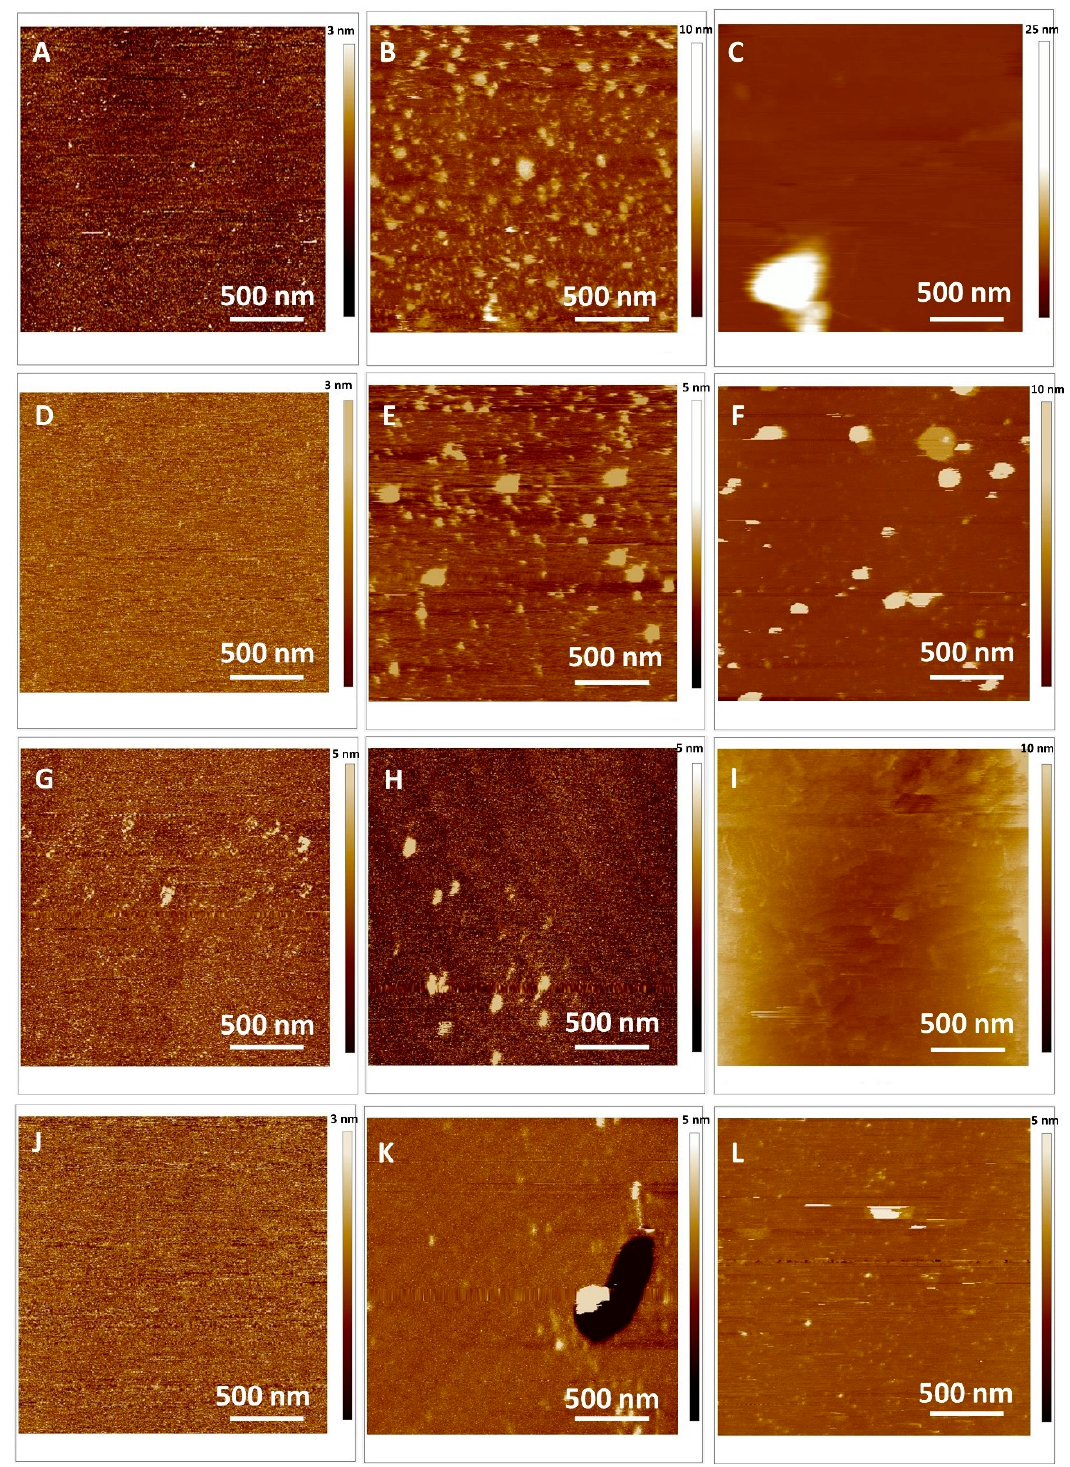
Figure 6. Top view of 2D height AFM images on the model (DOPC) SLB: ( A – C ) Control, ( D – F ) quercetin loaded DOPC; ( G – I ) myricetin loaded DOPC and ( J – L ) myricitrin loaded DOPC. The lipid peroxidation induced by ( B , E , H , K ) H 2 O 2 , ( C , F , I , L ) H 2 O 2 and Cu 2+ .